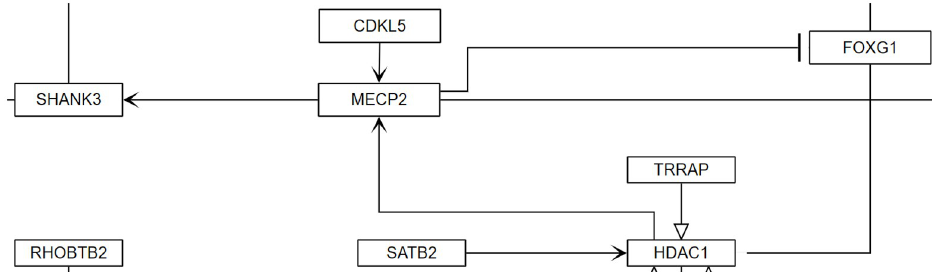
Fig 4. Example of direct interactions of gene products that both influence MECP2 and are influenced by MECP2 from Rett syndrome causing genes (wikipathways:WP4312). In this example, MECP2 is being influenced by HDAC1 and CDKL5. MECP2 then in turns influences SHANK3 and inhibits the activity of